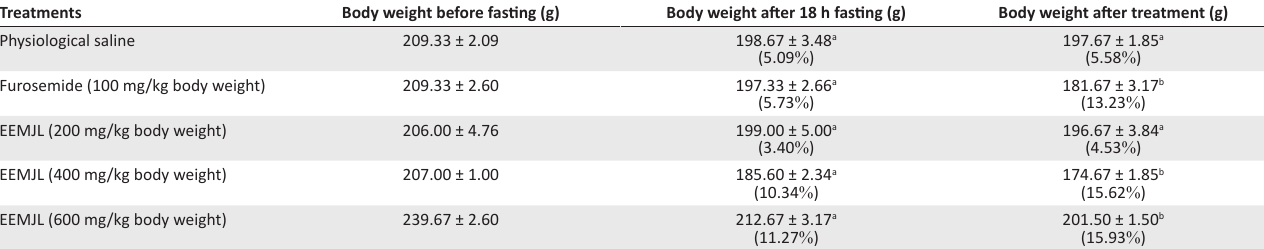
TABLE 1: Body weight of male rats after fasting and administration of ethanol extract of Mirabilis jalapa leaf. Treatments